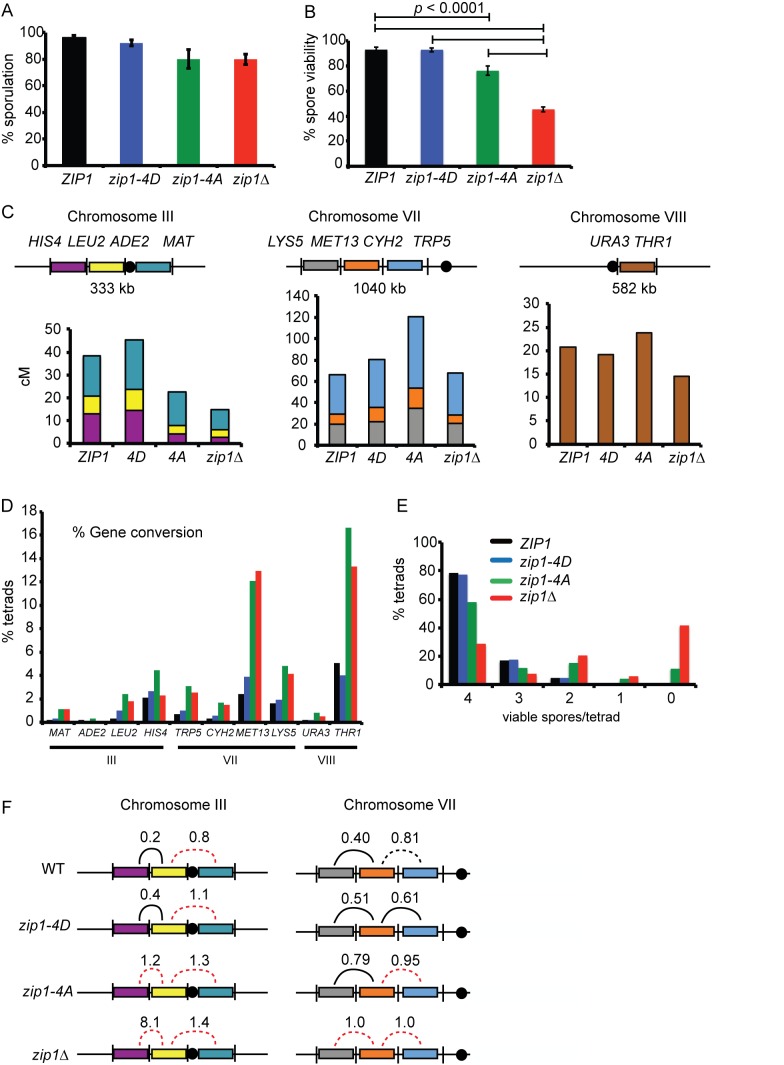
Genetic analysis of sporulation, spore viability, and recombination in various zip1 diploids.(A) ZIP1 (NHY957), zip1-4D (NH2241::p382), zip1Δ (NH2241::pRS304), and zip1-4A (NH2241::p382-4A) were sporulated for 2 d at 30°C. Average sporulation from five independent colonies was graphed; error bars indicate the standard deviation. (B) Average spore viability calculated from dissection of nine independent transformants from each diploid. Brackets indicate strain pairs whose spore viability is significantly different (χ2; p < 0.0001). The number of tetrads dissected for each strain: ZIP1, 449; zip1-4D, 1,332; zip1-4A, 1,857; and zip1Δ, 4,012. The isogenic ZIP1 data shown in Panels B and E were previously published [35]. (C) Map distances for the indicated intervals on Chromosomes III, VII, and VIII were calculated using the formula from Perkins [36]. At least 940 tetrads were analyzed for each genotype. ZIP1 map distances were generated by pooling data from published NHY957 dissections [25,35,37]. p-Values indicating the significance between the map distances of different intervals for mutants and WT are shown in S1 Data. (D) The percent of four viable spore tetrads exhibiting non-2+:2− segregation (gene conversion) for the indicated loci. ZIP1 data were taken from [37]. (E) The distribution of viable spores in tetrads from the dissections shown in Panel B. (F) Interference values for adjacent intervals were calculated using the method of [38]. A solid line indicates interference was observed when either interval was used as the reference. A black broken line indicates interference was detected using one of the reference intervals. A red broken line indicates that no interference was observed using either reference interval. Numbers represent the average of the two ratios for that interval. Data for the ZIP1 strain in Panel F are from [37]. The aberrantly high value observed for the zip1Δ in the HIS4-LEU2/LEU2-CEN interval is likely due to the chance occurrence of an extra nonparental ditype (NPD).